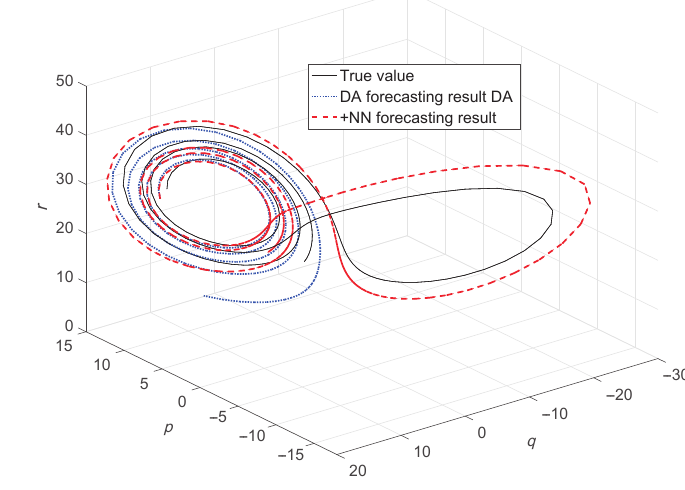
(b) Trajectories of DA and DA with NN forecasting. It is the 3D-plot of Fig. 4a for timestep ∈ (1000, 1176). Fig. 4 Result of data assimilation with NN on Lorenz